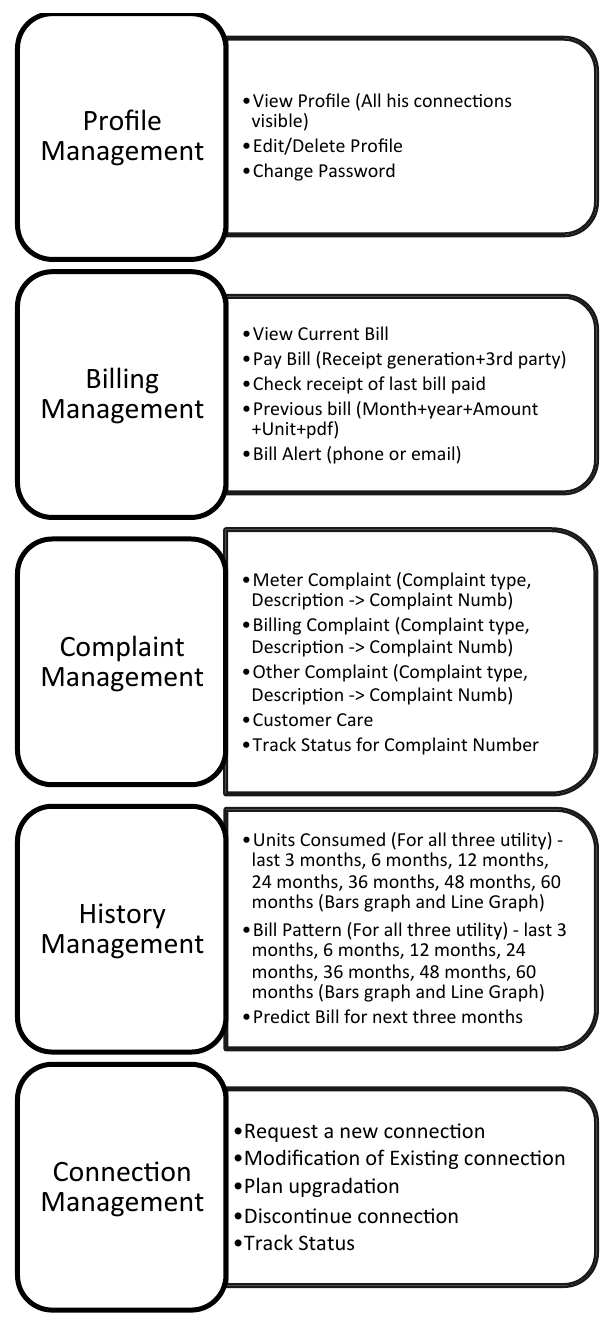
Figure 20. Various options for the user entering into